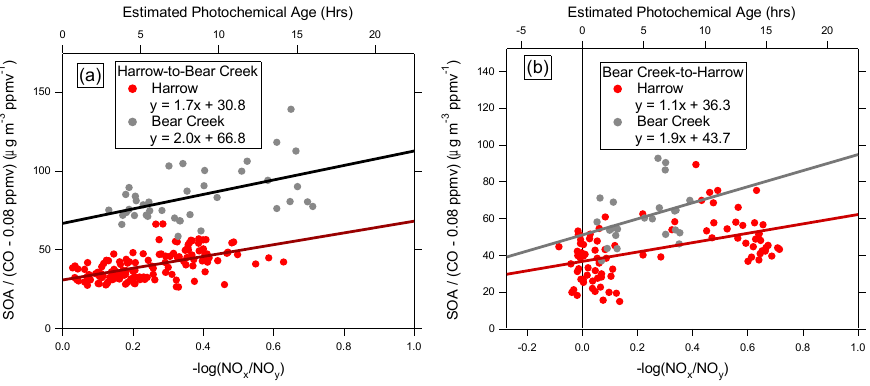
Fig. 8. Photochemical aging during periods of transport between Harrow and Bear Creek. As in Fig. 6, SOA is estimated as OOA-1 + OOA- 2 + UNKN. Similar slopes represent similar responses to local processing, reflected in the NO x /NO y ratio. Differences in the y-intercepts represent airmass processing during inter-site transport, as discussed in the text. Figure 8a shows the Harrow-to-Bear Creek period (see Fig. 3 red period, and Fig. 5); Fig. 8b shows Bear Creek-to-Harrow (see Fig. 3 green period, and Fig. 4). For curve fitting results, slopes are reported in µgm − 3 ppmv − 1 h − 1 and intercepts are in µgm − 3 ppmv − 1